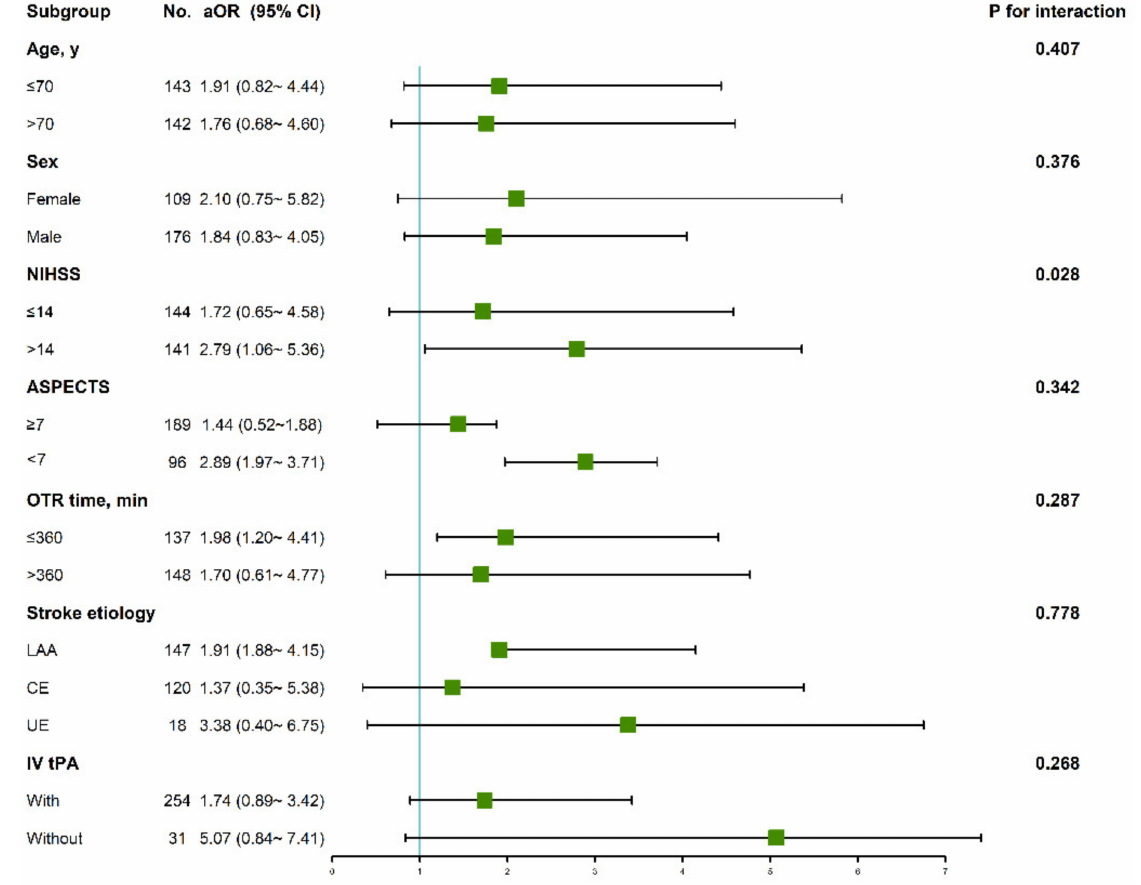
Figure 2. Forest plot aOR, adjusted odds ratios of tirofiban for favorable outcome. Adjusted for age, NIHSS, ASPECTS, stroke etiology, administration of tirofiban, OTP time, OTR time, TICI 2b-3. NIHSS, National Institutes of Health Stroke Scale; ASPECTS, Alberta Stroke Program Early Computerized Tomography Score; CI, confidence interval; OTP, time from onset to groin puncture; OTR time from onset to recanalization; TICI, Thrombolysis in Cerebral Infarction